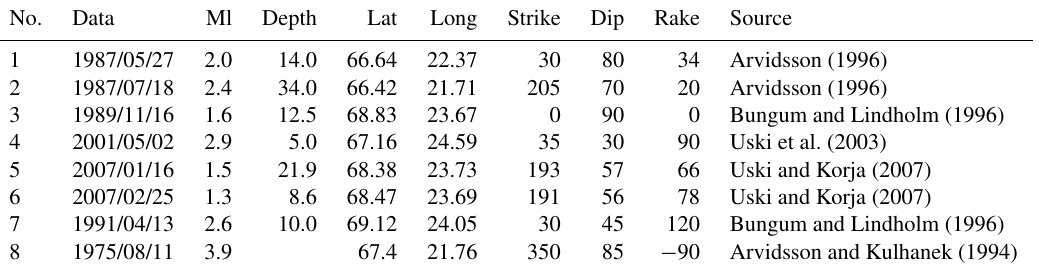
Table 5. Information about focal mechanisms of local earthquakes for Region 2 from other sources. No. Data Ml Depth Lat Long Strike Dip